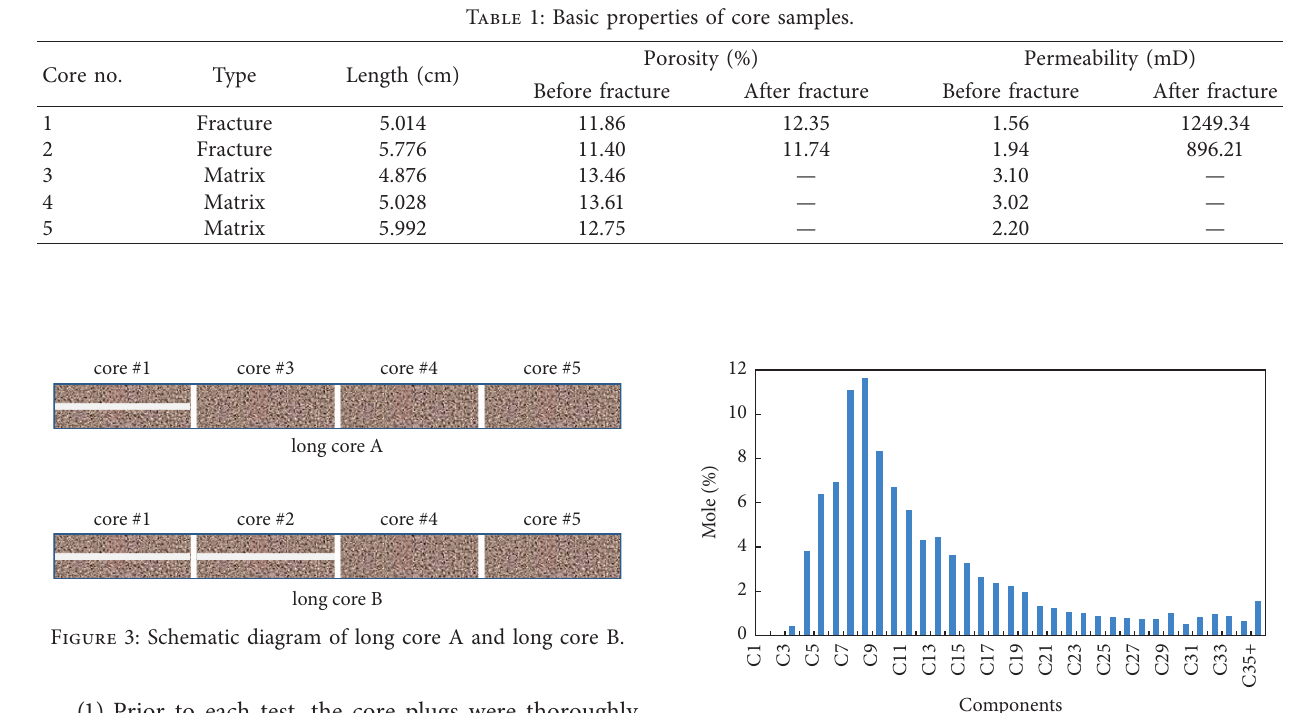
Figure 4: Components of the oil sample under the temperature of 21 °